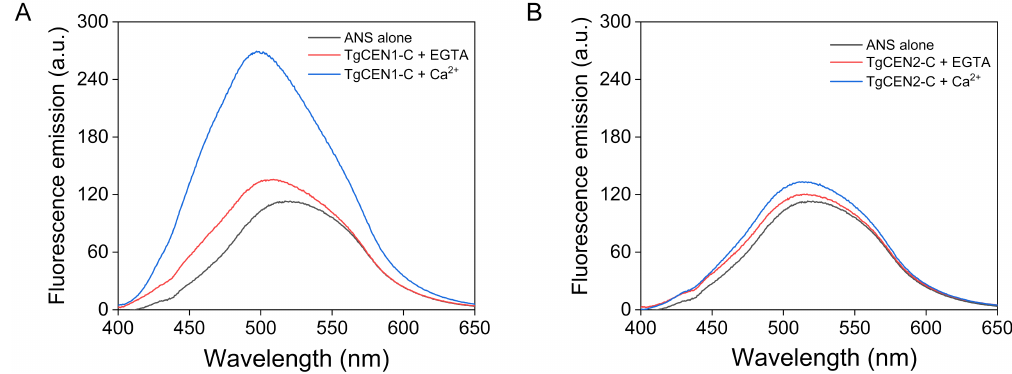
Figure 5. Fluorescence emission of ANS. Representative ANS fluorescence spectra of TgCEN1-C ( A ) and TgCEN2-C ( B ) in the presence of 2 mM EGTA (red) or 2 mM CaCl 2 (blue). The spectra of ANS alone (black) is also